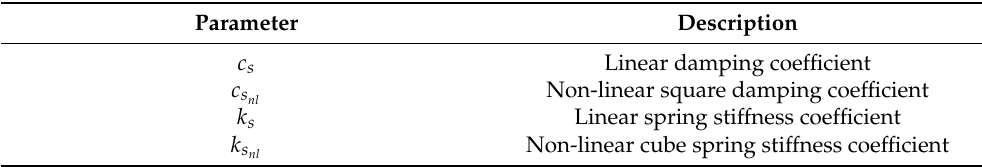
Table 2. 2DOF QC model unknown parameters. Parameter